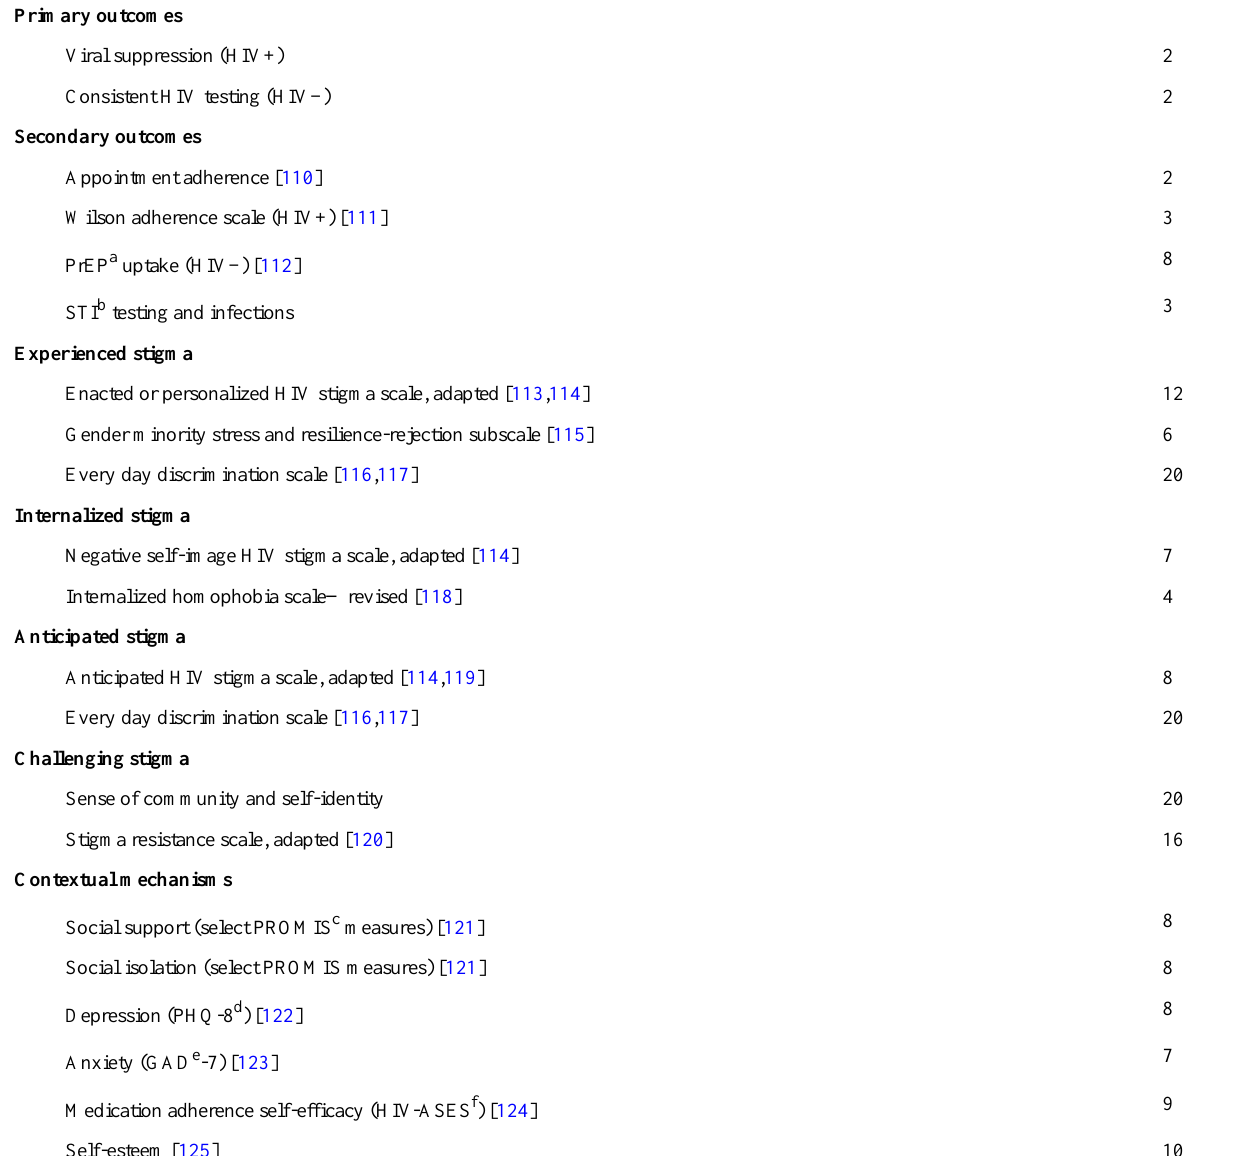
Table 3. Study measures for HealthMpowerment 2.0 randomized controlled trial. ItemsVariables and